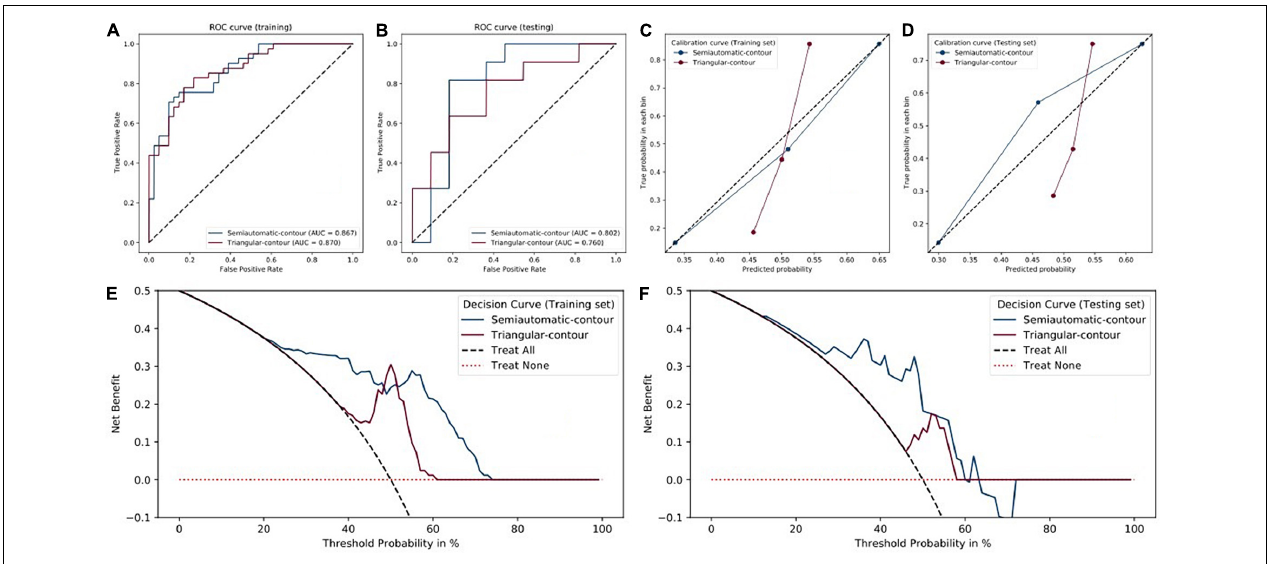
FIGURE 3 | Performance of triangular-contour (red) and semiautomatic-contour (blue) models. (A,B) The ROC curves of the training and testing sets. (C,D) Calibration curves. (E,F) Decision curves. TABLE 3 | Comparisons of radiomics models for semiautomatic and triangular contour in the training and testing set. Model AUC (95% CI) SD Accuracy F1-score Sensitivity Specificity Threshold Training